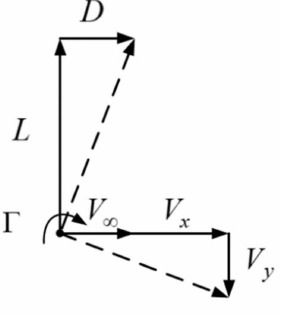
Figure 18. Induced drag of airfoil in jet